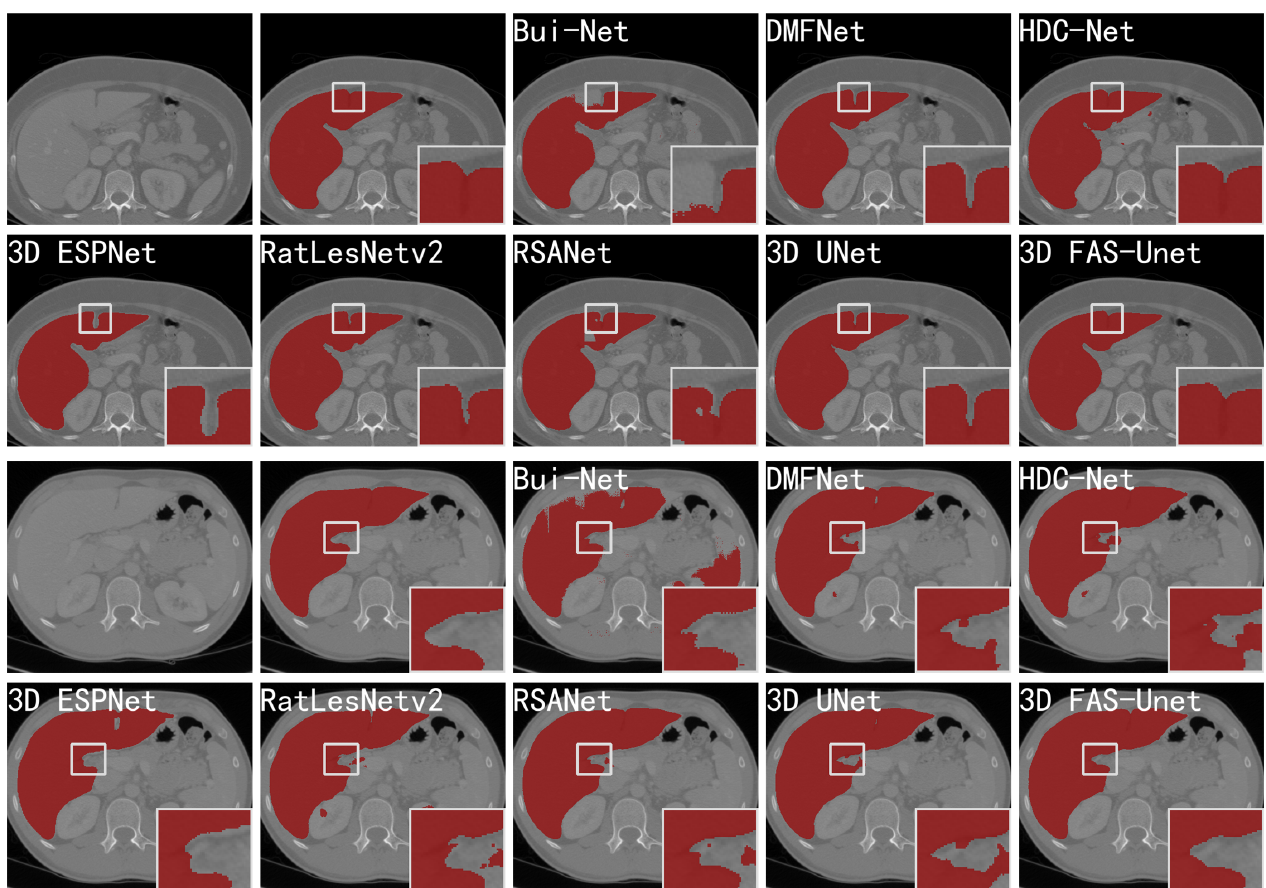
Figure 5. Visualizations (without post-processing) of different methods for liver CT segmentation of two slices. From left to right in the first and third rows: the original images, ground-truth, the segmentation results of skip-connected 3D DenseNet, DMFNet, and HDC-Net, respectively. From left to right in the second and fourth rows: the segmentation results of 3D ESPNet, RatLesNetv2, RSANet, 3D UNet, and 3D FAS-UNet, respectively.